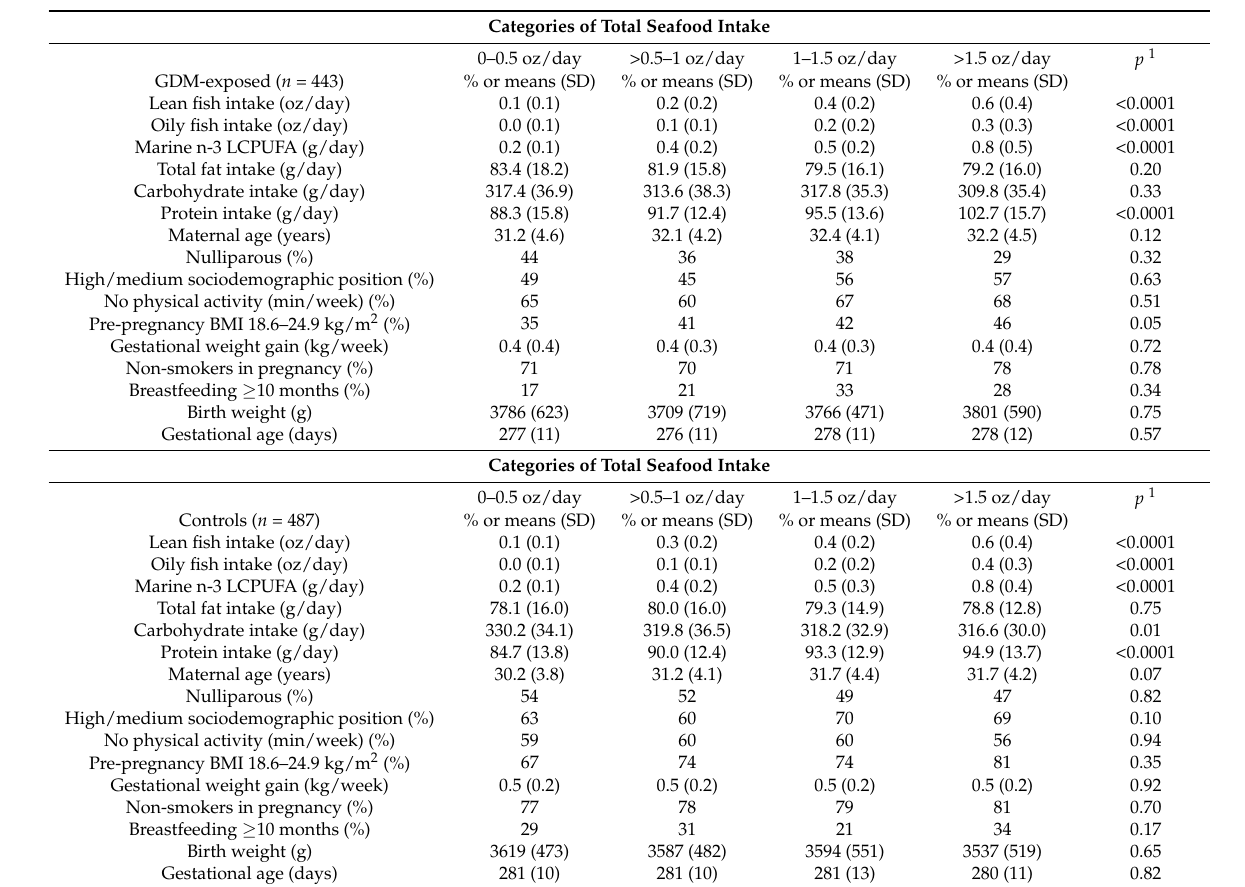
Table 1. Maternal characteristics distributions across quartiles of total seafood intake in gestational week 25 across gestational diabetes mellitus (GDM)-exposed and control